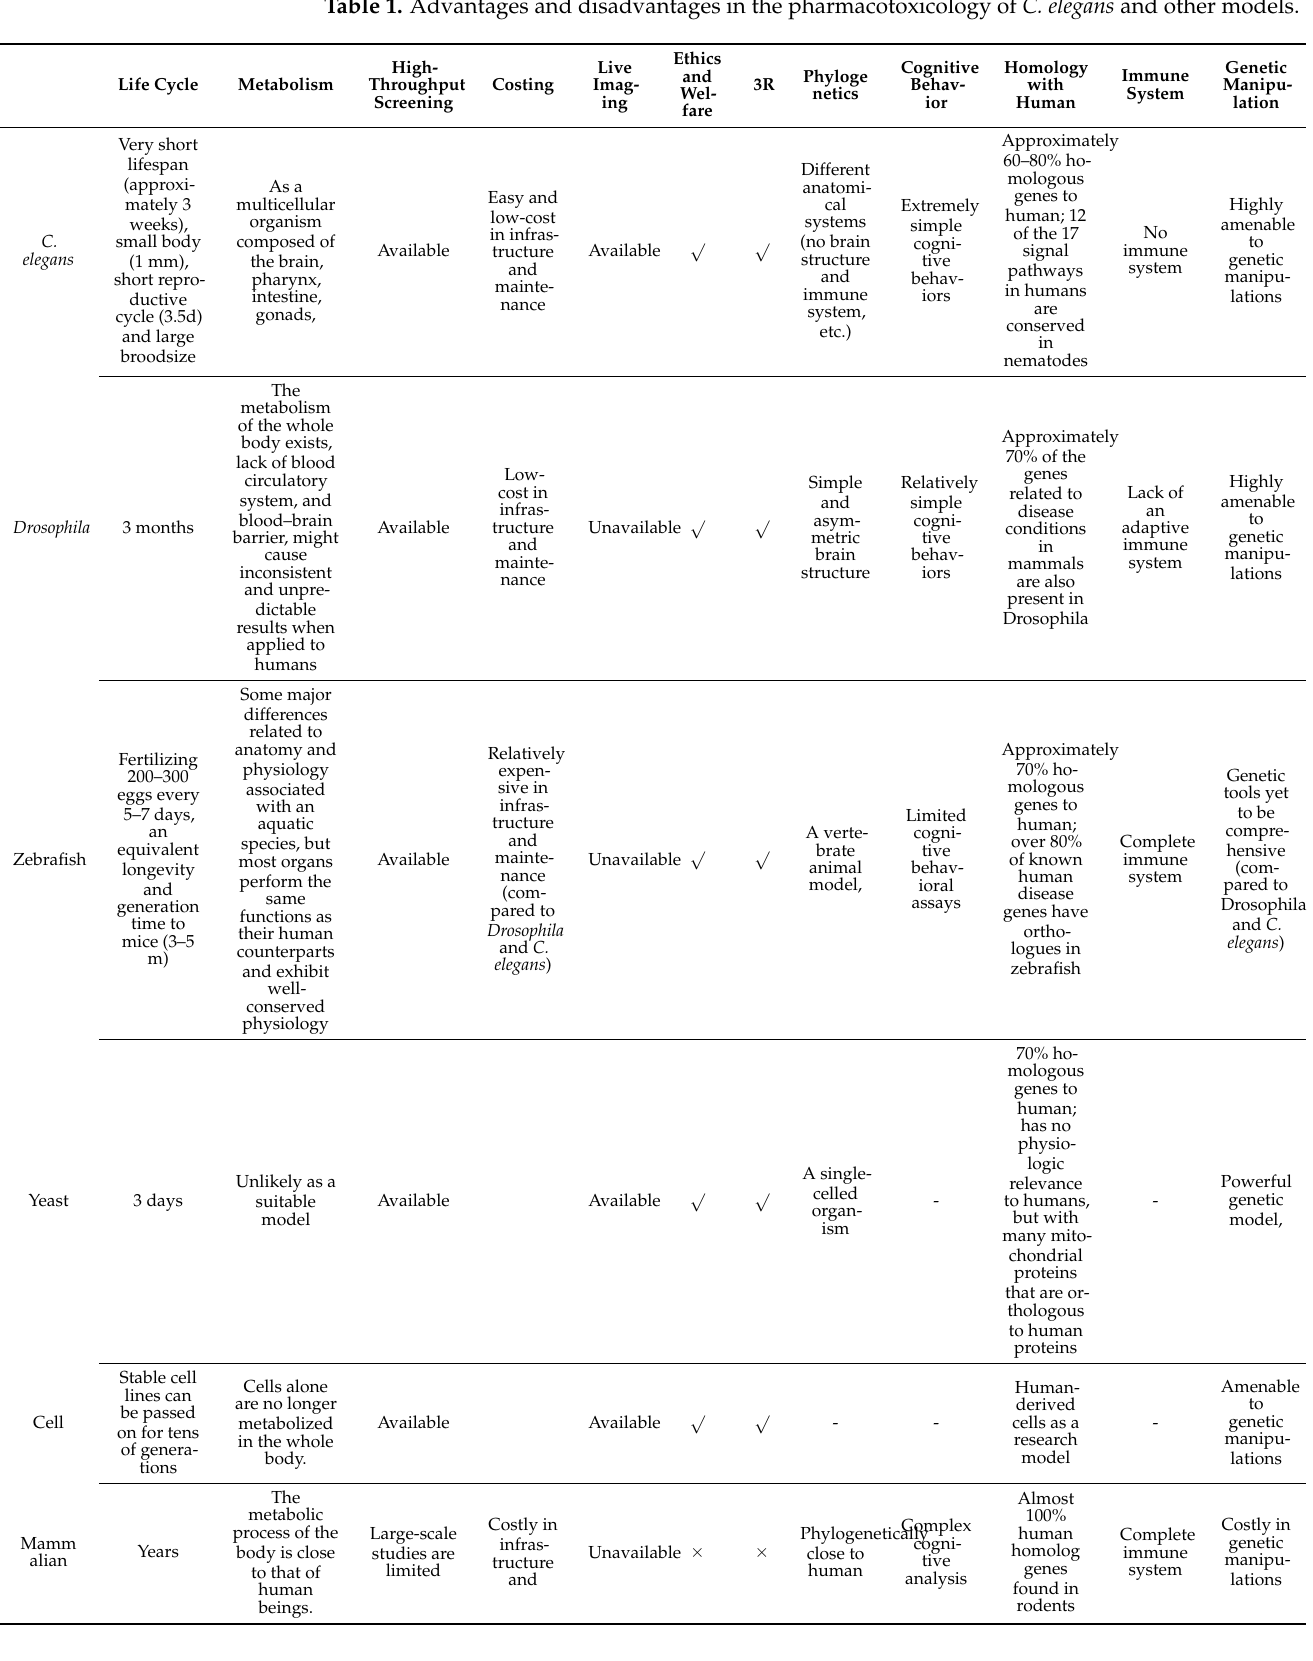
Table 1. Advantages and disadvantages in the pharmacotoxicology of C. elegans and other